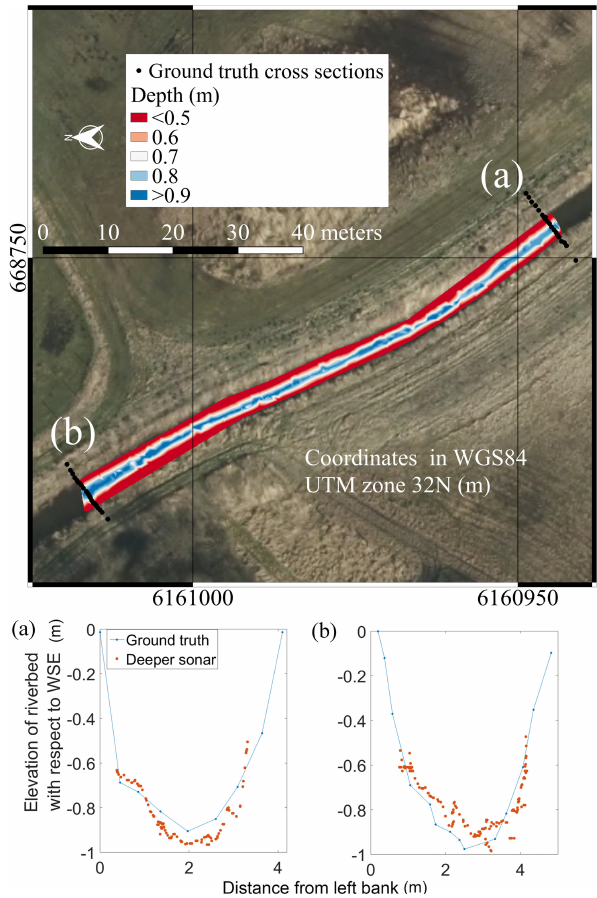
Figure 12. Bathymetry observations in Åmose Å. Top panel shows the surveyed river stretch (north direction pointing towards the left side of the map as indicated by the north arrow). Background map is an airborne orthophoto provided by the Danish Styrelsen for Dataforsyning og Effektivisering (https://kortforsyningen.dk/, last access: 6 September 2017). Raster foreground map shows UAV- borne observations interpolated with the triangulated irregular net- work method. Two ground truth cross sections were retrieved, which are shown in the bottom panels: (a) upstream and (b) down- stream cross section. In the cross section plots, the x axis shows the distance from left bank (west bank), and the y axis shows the differ- ence between riverbed elevation and WSE (opposite sign of water